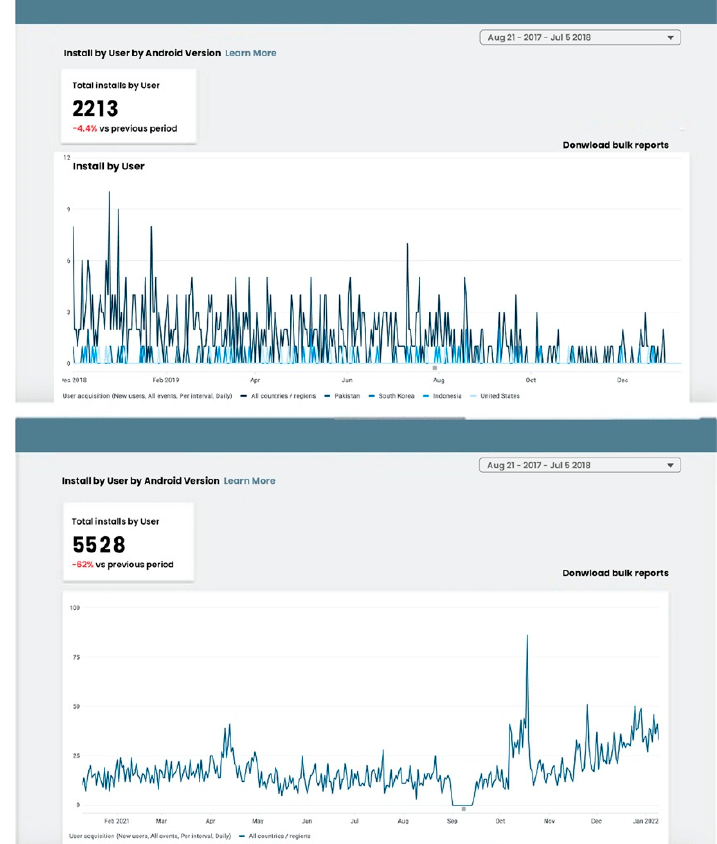
Figure 5. App downloads from account 1.